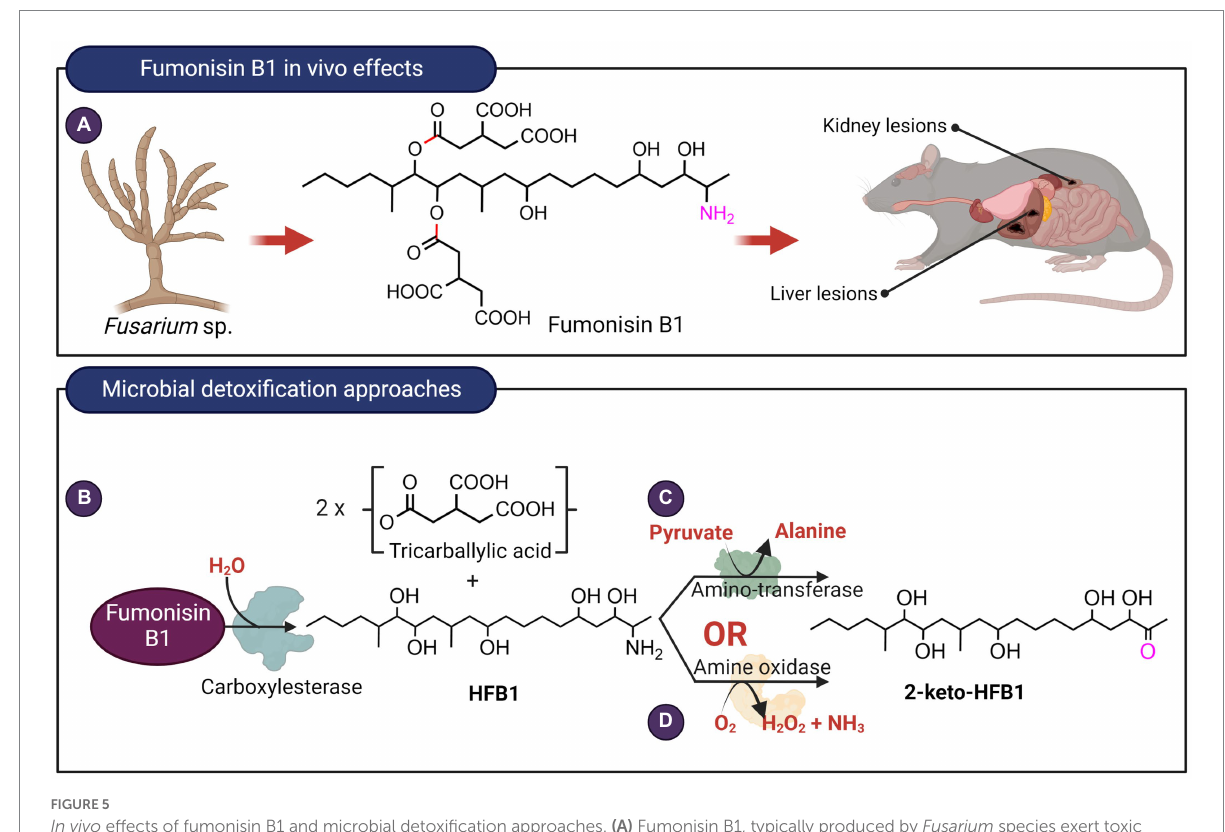
FIGURE 5 In vivo effects of fumonisin B1 and microbial detoxification approaches. (A) Fumonisin B1, typically produced by Fusarium species exert toxic effects on the liver as well as kidneys. (B) Hydrolysis of fumonisin B1 catalyzed by carboxyesterases target the ester linkages highlighted in red. Deamination reaction catalyzed by (C) aminotransferase or (D) an amine oxidase with the targeted C2 amino group highlighted in fuschia. The aminotransferase and amine oxidase from Sphingopyxis sp. MTA144 and Exophiala spinifera utilize hydrolyzed fumonisin B1 as